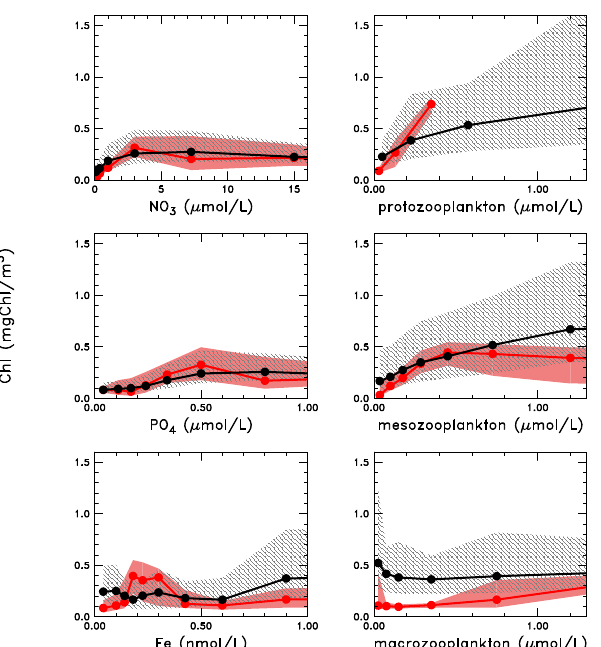
Figure 3. Covariation between Chl concentration and (left) poten- tially limiting nutrients and (right) biomass of zooplankton groups for the World Ocean. Chlorophyll data from SeaWiFS satellite are the same in each panel, and are averaged over 1998–2009. The NO 3 and PO 4 data are from the World Ocean Atlas 2009, updated from (Garcia, 2006b). Fe data are from (Tagliabue et al., 2012). The protozooplankton biomass data are updated from Buitenhuis et al. (2010), the mesozooplankton biomass data from Buitenhuis et al. (2006), and the macrozooplankton biomass data include all krill data from Atkinson et al. (2004) and other crustacean data from Moriarty et al. (2013). All data are monthly averages except for the mesozooplankton, which are seasonal. All data are for the surface, generally corresponding to the mixed layer, except for ob- served Chl, which is seen by satellite over one optical depth, and observed mesozooplankton and macrozooplankton, which are from depth-integrated tows and may underestimate surface concentra- tions (by a factor 1.5–2; see text). The black lines are medians, and grey shadings the 25–75% interquartile range for Chl concentra- tion. The median from the PlankTOM10 model is shown in